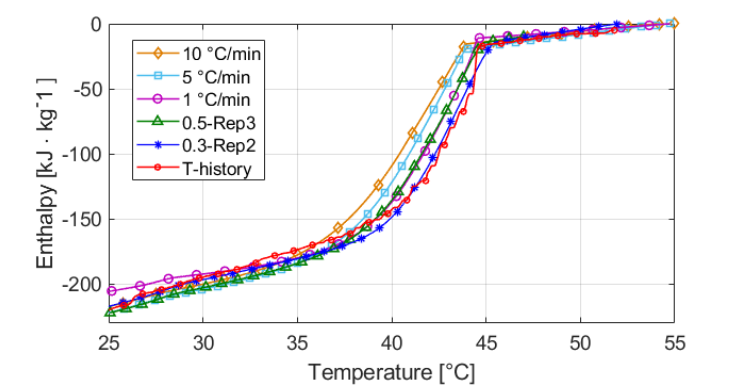
Figure 17. Enthalpy-Temperature comparison between DSC and the T-history